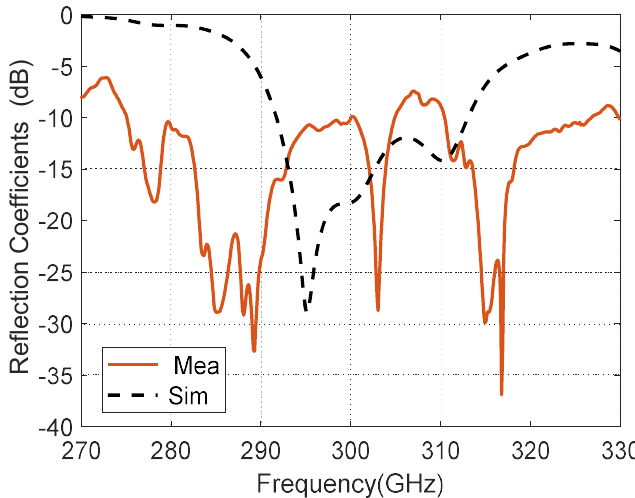
Figure 3. Measured and simulated of the reflection coefficients (S11) of the CP-RCA.